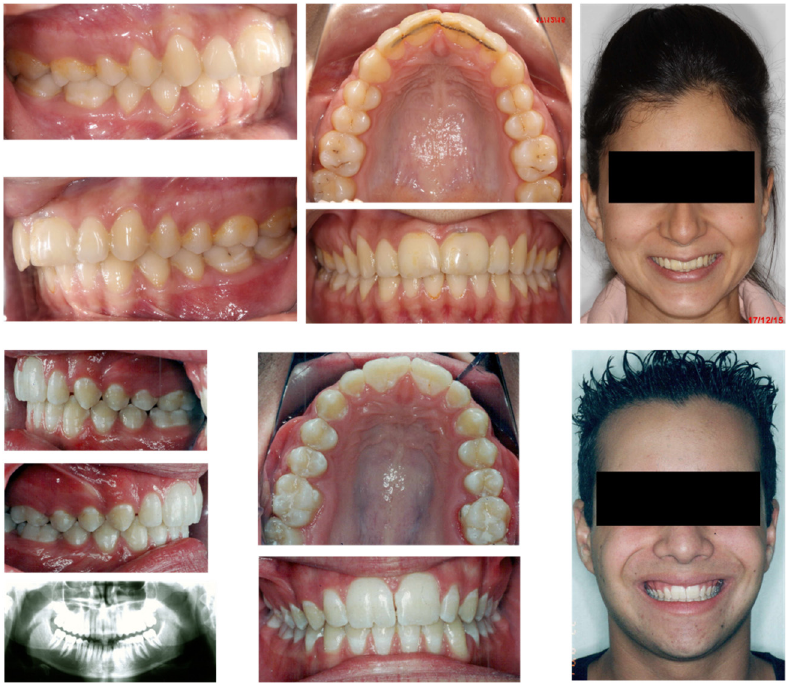
Figure 3. Geminated upper central incisors at 15 years ( bottom ) and 11 years ( top ) after the end of treatment; a stable and aesthetic